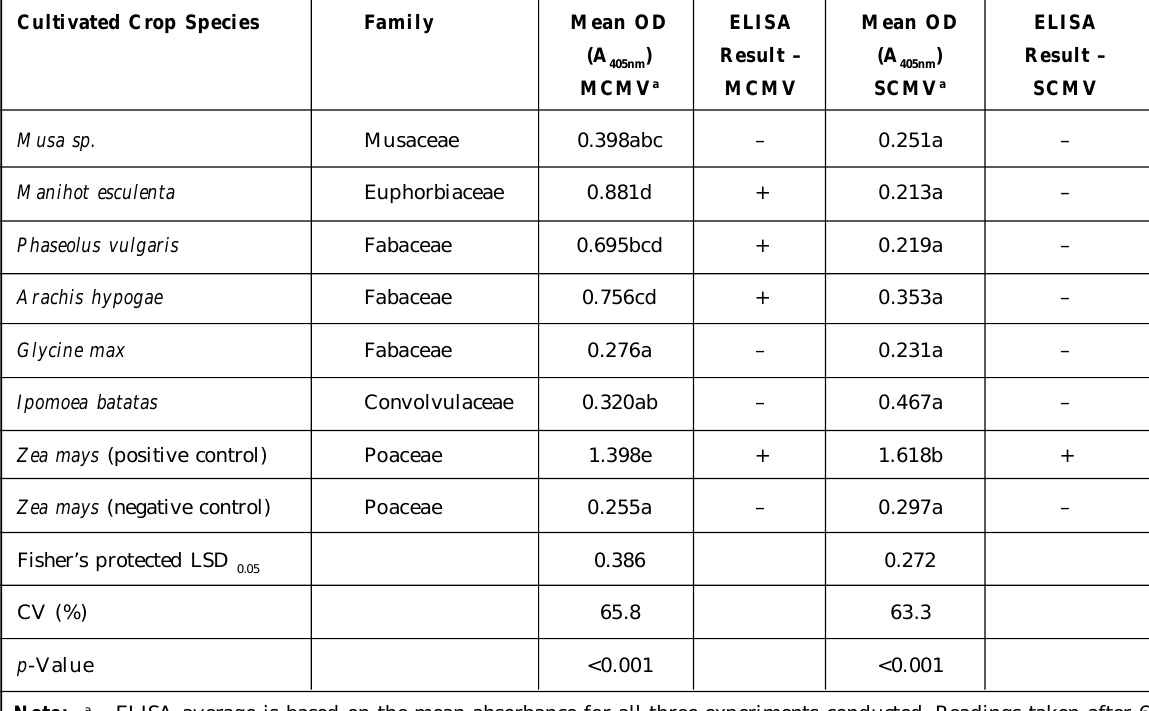
Table 5: Susceptibility of common cultivated crop species to Maize chlorotic mottle virus and Sugarcane mosaic virus based on ELISA test following mechanical inoculation with MLN Cultivated Crop Species